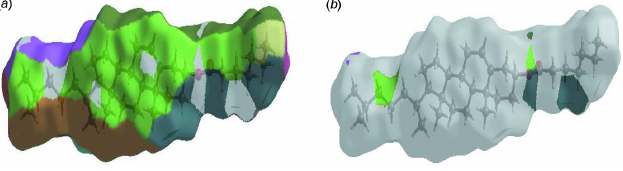
Figure 5 The Hirshfeld surface representations with the function d norm plotted onto the surface for ( a ) H (cid:2)(cid:2)(cid:2) H and ( b ) H (cid:2)(cid:2)(cid:2) O/O (cid:2)(cid:2)(cid:2) H interactions.